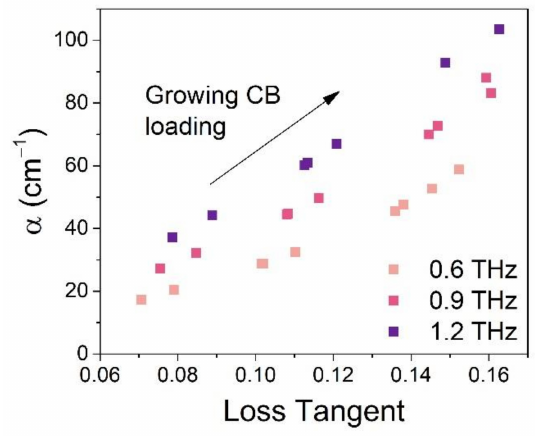
Figure 6. Relation between absorption coefficient and the loss tangent shown at three frequencies— 0.6, 0.9 and 1.2